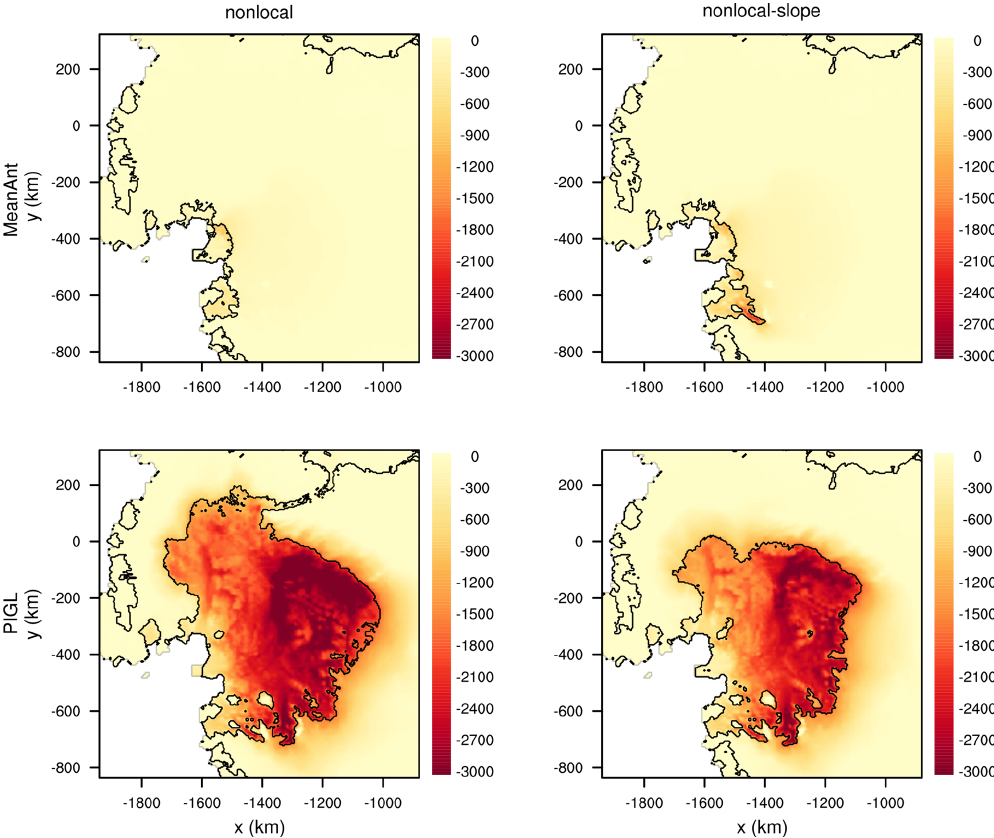
Figure 22. Difference in ice thickness (m) between the years 2500 and 1950 in projection experiments with a Coulomb friction law ( p = 1) and with δT sector = 0 for the Amundsen sector to provide a 2 ◦ C anomaly relative to the spin-up. No ESM ocean forcing anomaly is applied, so the response is limited to the Amundsen sector. The four panels correspond to the nonlocal and nonlocal-slope melt parameterizations with the MeanAnt and PIGL calibrations. Black lines show boundaries of floating ice at the end of each